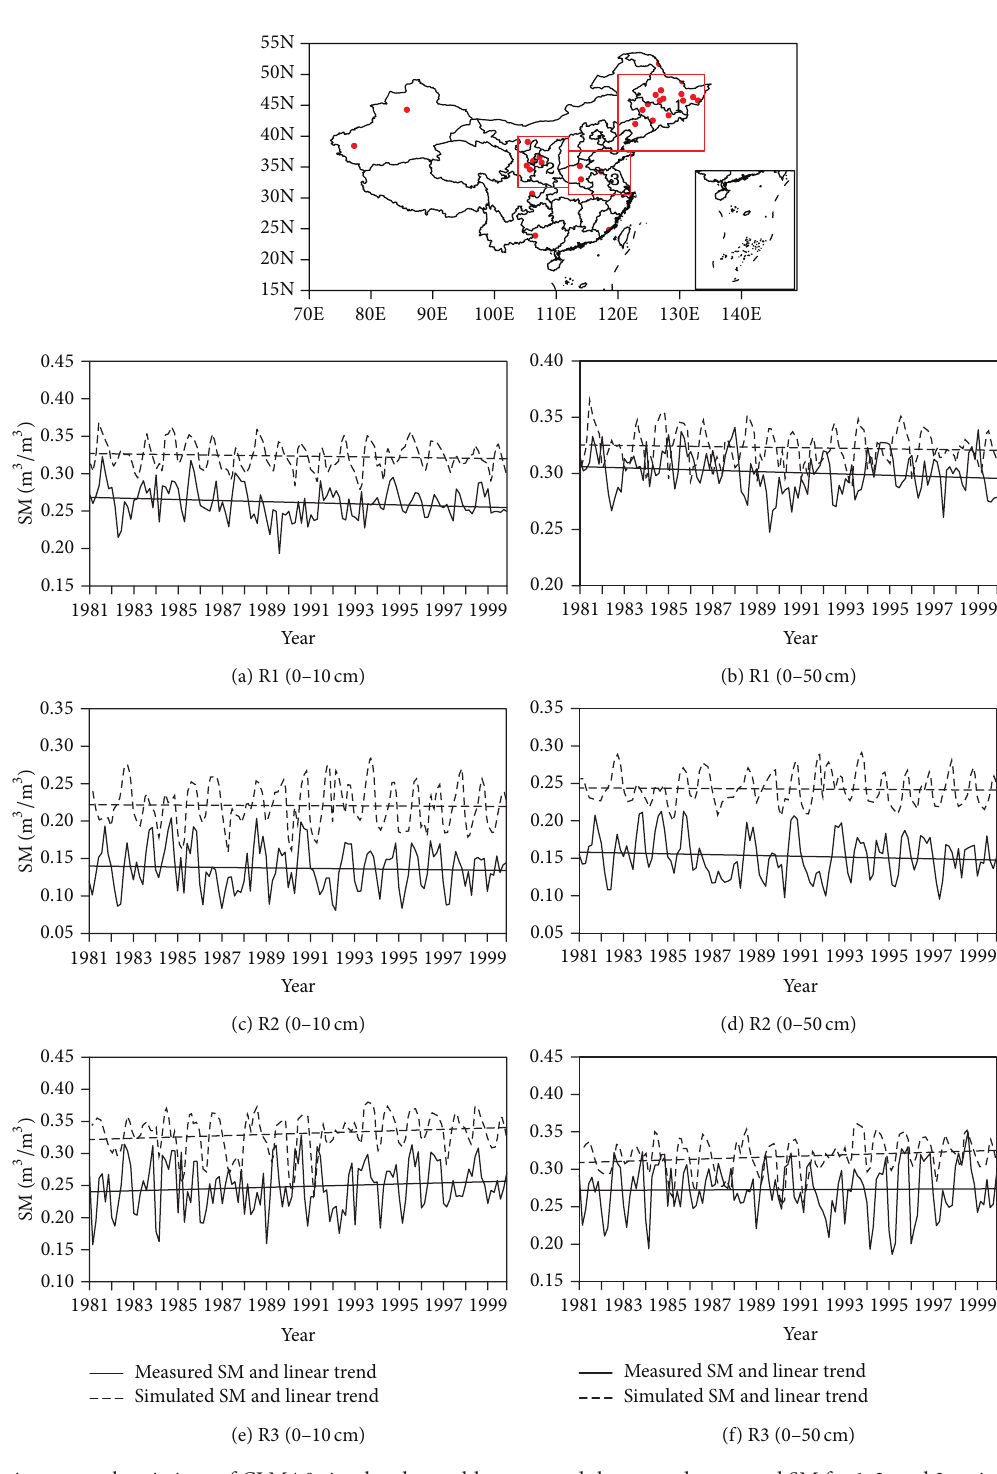
Figure 4: The interannual variations of CLM4.0 simulated monthly mean and the ground measured SM for 1, 2, and 3 regions (a, c, and e) 0–10 cm depth; (b, d, and f) 0–50 cm